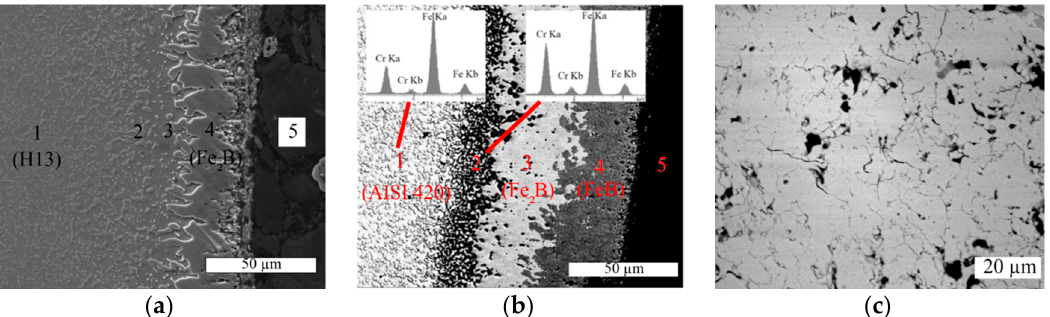
Figure 2. ( a ) Iron boride layer on H13, SEM, secondary electrons, cross section; ( b ) iron boride layers on AISI 420, SEM. Backscattered electrons mode is selected, in order to show the double boriding layer, cross section; ( c ) cross-section of YSZ showing the porosity.